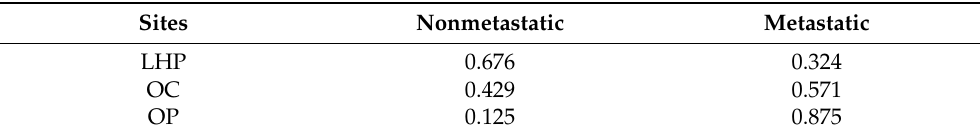
Table 2. Conditional probabilities of lymph node metastasis given the tumor site (LHP: larynx or hypopharynx; OC: oral cavity); OP: